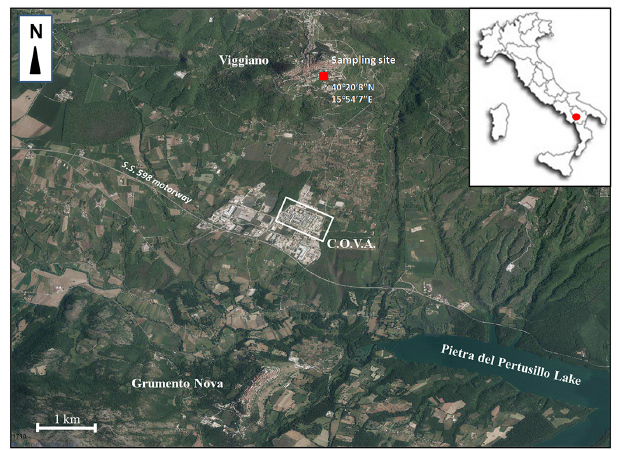
Figure 1. Location of the sampling site and Agri Valley pre- treatment plant (C.O.V.A). Copyright AGEA – Orthophoto